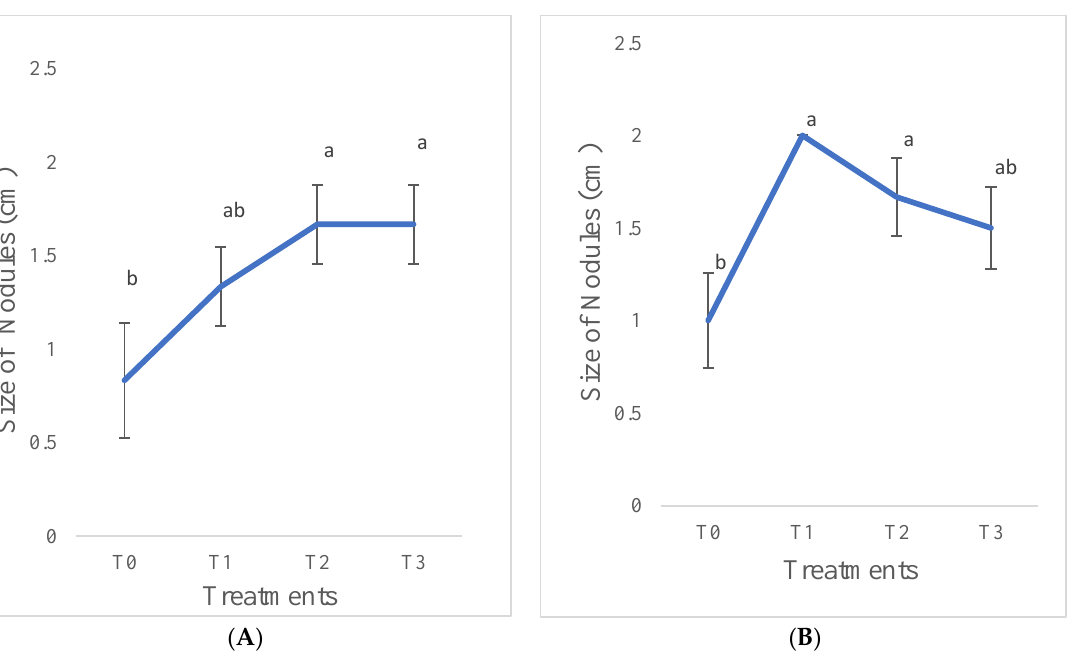
Figure 3. Root length of lucerne under inoculation with liquid formulation (T0, T1, T2, and T3) of Sinorhizobium meliloti in climatic zone ( A ) = Bronkhorspruit/Gauteng and ( B ) = Hartbeesfoein/North- West Province). Bars sharing a letter are not significantly different (Lsd Zone A) = 12.322 and (Lsd Zone B) = 10.949. Data are means ± standard errors.